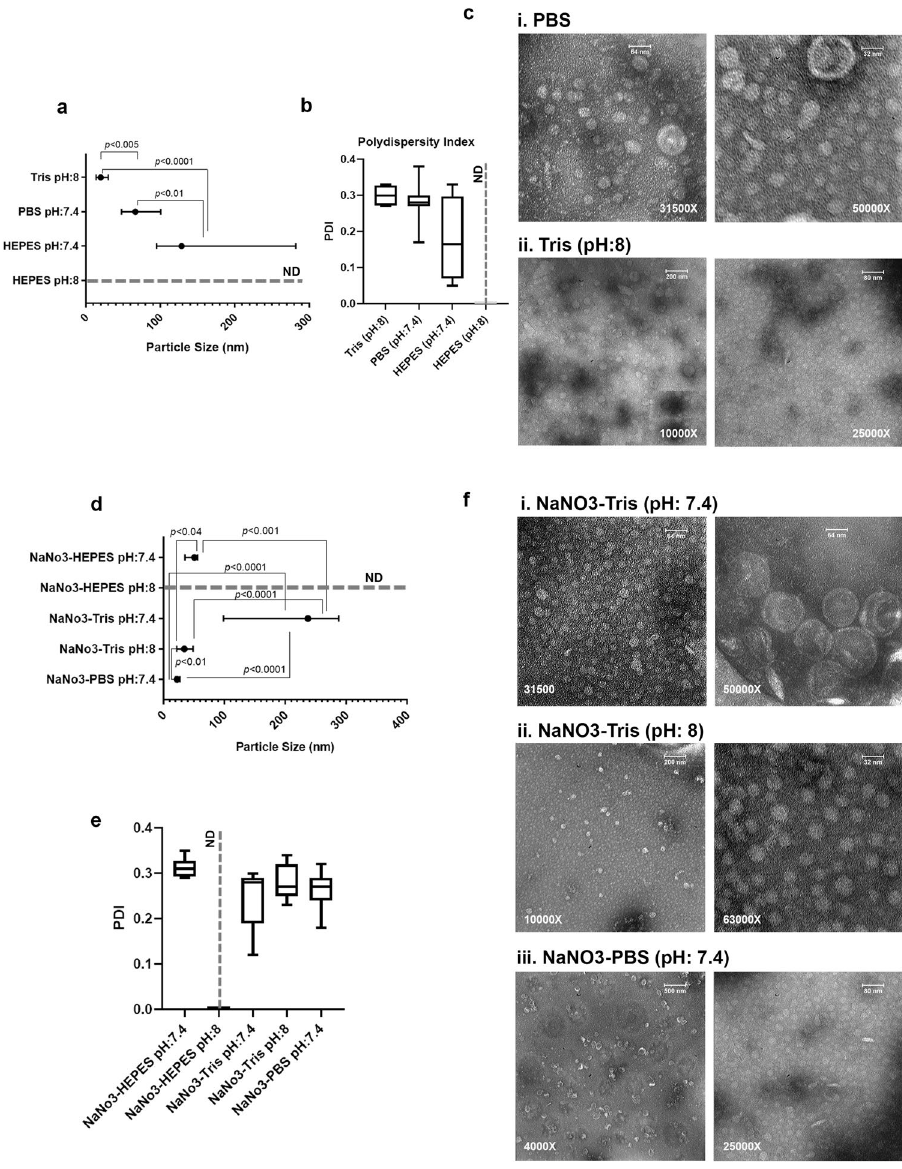
Figure 2. VLPs produced in NaNO3-Tris buffer showed the best shape, particle size consistency, and dispersity. ( a ) The size was detected in Tris (pH:8), PBS (pH:7.4), HEPES (pH:7.4), and HEPES (pH:8). The size of VLPs in HEPES (pH:8) was out of range (> 1000 nm), and not detectable (ND). Results are shown as median with range, p < 0.01, p < 0.005, and p < 0.0001. ( b ) Polydispersity Index (PDI) of VLPs in different Buffers. ( c ) VLP suspension in i) PBS (pH:7.4) and ii) Tris (pH:8). Particles below 100 nm were observed by TEM. ( d ) The particle size of VLPs prepared in 100 mM NaNO3 mixed with buffers. The size of particles in NaNO3- HEPES (pH:8) was extra-large, out of range (> 1000 nm), and not detectable (ND). Results are shown as median with range, p < 0.04, p < 0.01, p < 0.001, p < 0.0001. ( e ) The PDI value of various VLP suspensions was measured. ND: not detectable. ( f ) VLP suspensions with a size below 100 nm were investigated by TEM. i) VLPs in NaNO3-Tris (pH:7.4), ii) VLPs in NaNO3-Tris (pH:8), iii) VLPs in NaNO3-PBS